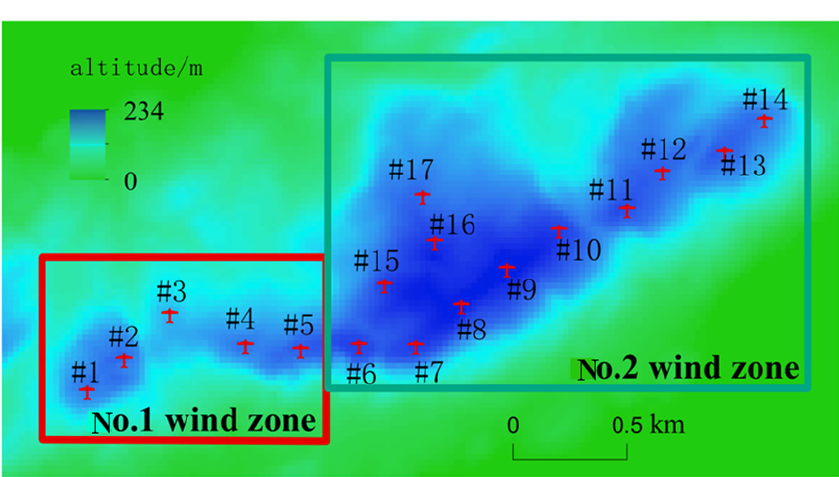
Figure 8. Zoning result of the island wind farm.